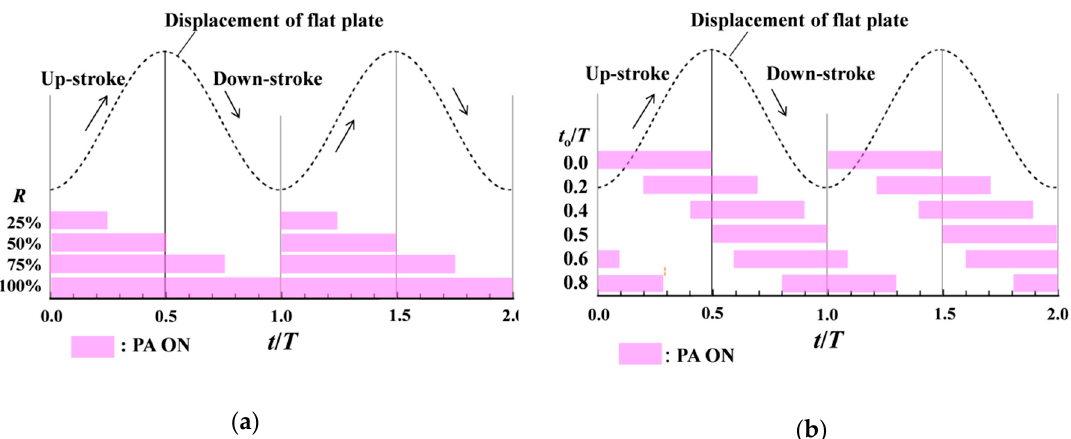
Figure 4. The driving conditions of plasma actuators for two periods (2 T ), where T is an oscillating period and t = 0 represents the time for the bottom dead center of the oscillating motion. ( a ) Conditions with varied driving ratio ( t 0 / T = 0.0); ( b ) Conditions with varied time offset ( R = 50%).